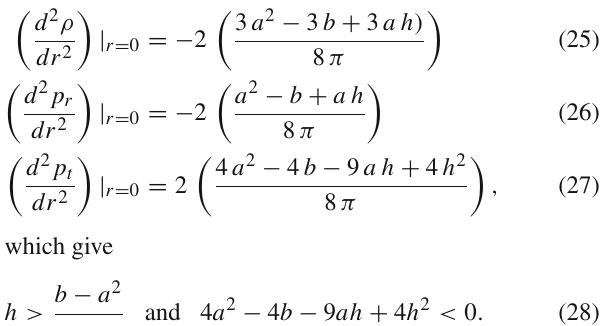
Fig. 2 Behavior of pressures (radial pressure ( p r ) and tangential pres- sure ( p t )) versus radial coordinates r / R . For plotting of this figure, the corresponding values of arbitrary constants or parameters are displayed in Table 1